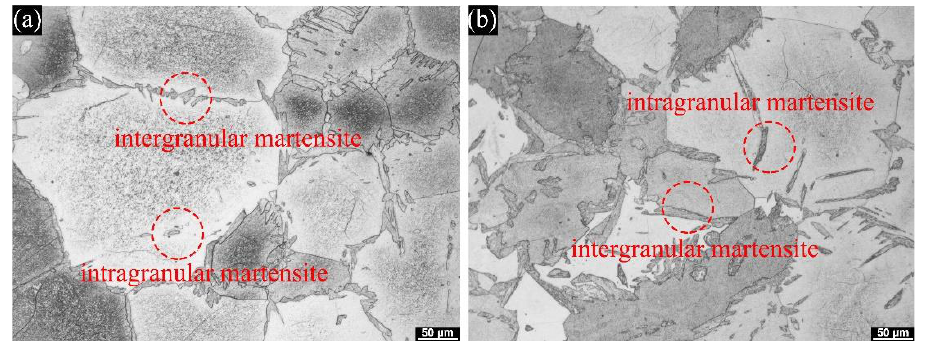
Figure 8. Microstructure of the coarse-grain zone in the HAZ: ( a ) without ultrasonic treatment and ( b ) with ultrasonic treatment.